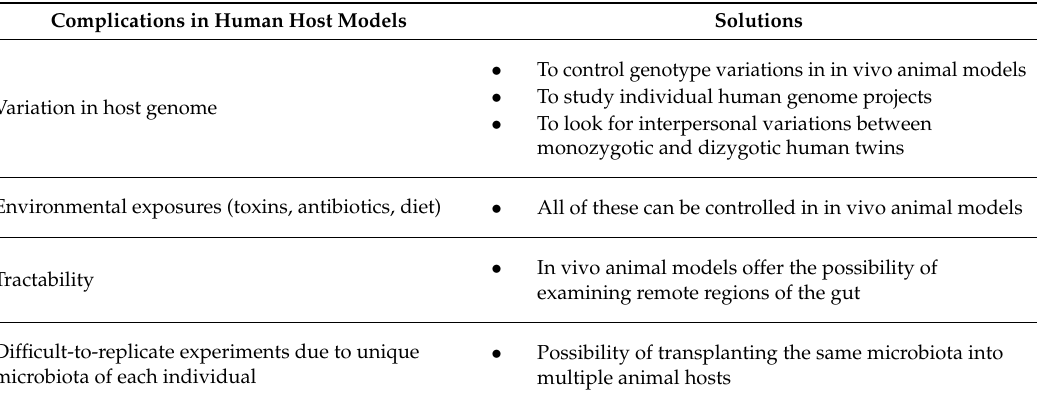
Table 1. Main complications in microbiota research using human individuals